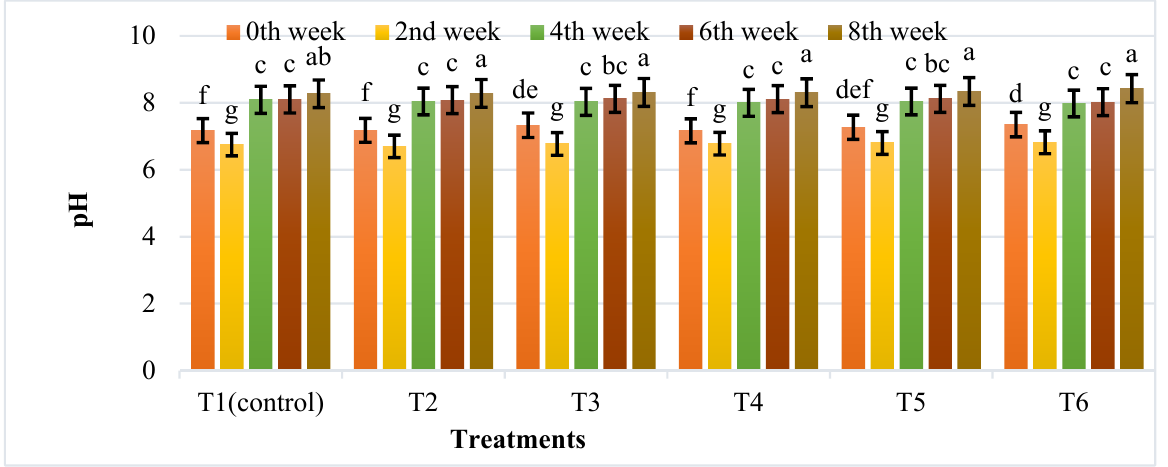
Figure 9. The effects of different IONPs treatments on the pH value of cattle manure during anaerobic digestion. Bars with different letters depict significantly different values at p ≤ 0.05.